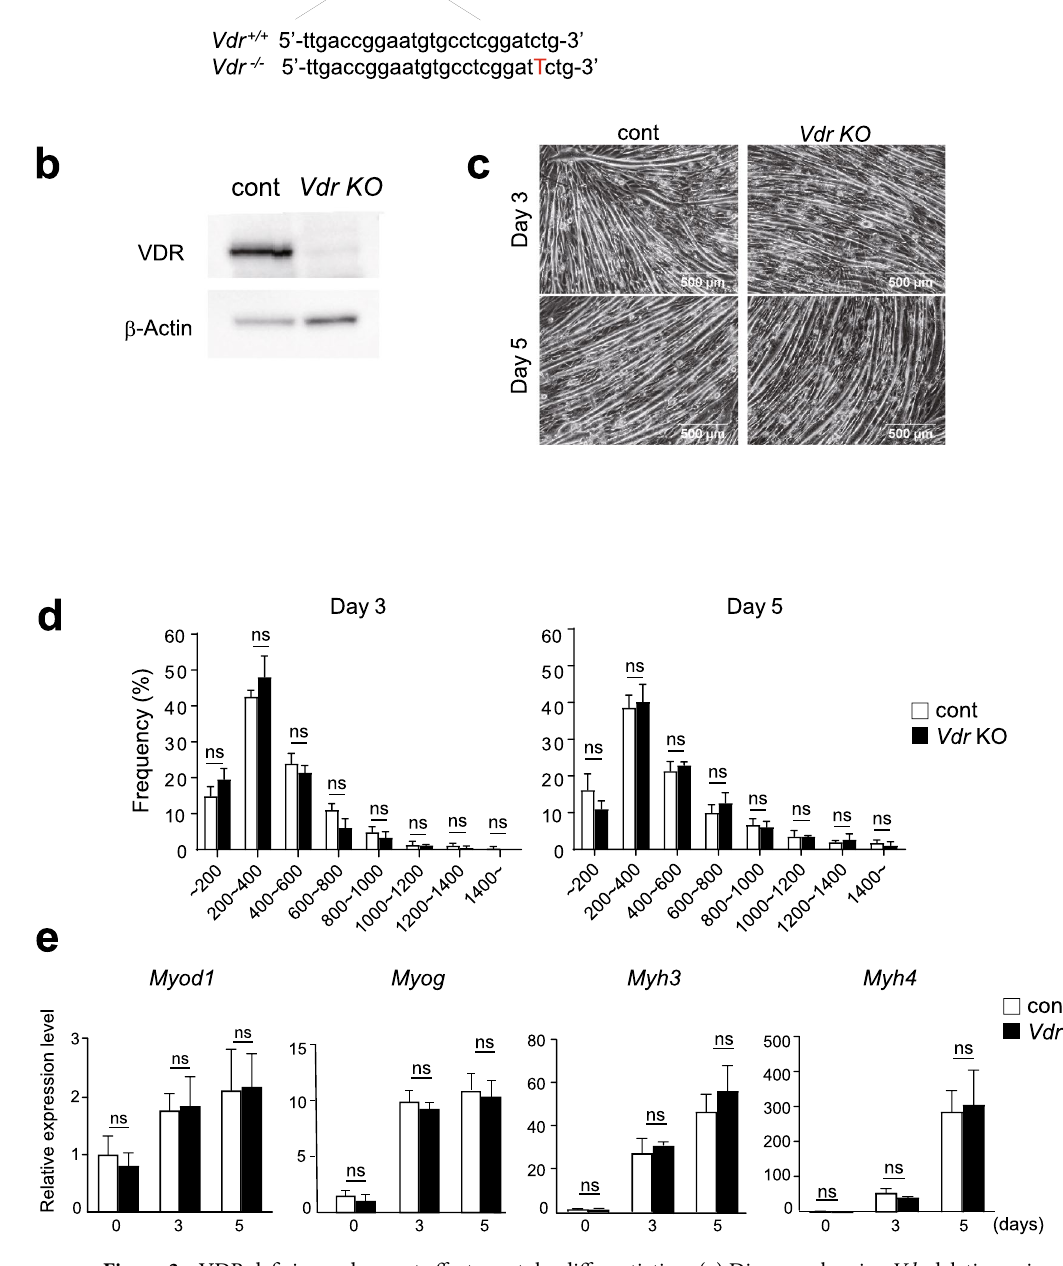
Figure 3. VDR deficiency does not affect myotube differentiation. ( a ) Diagram showing Vdr deletion using the CRISPR-Cas9 system. ( b ) Western blot of VDR and β-Actin in C2C12 myotubes confirming that VDR expression was absent in Vdr KO cells. ( c ) Phase contrast images of control and Vdr KO C2C12 cells after differentiation for 3 or 5 days. Scale bars; 500 μm. ( d ) Distribution of myotube lengths. Data are means ± s.d. Mean numbers of myotubes within the indicated length ranges per 100 myotubes in control and Vdr KO C2C12 cells after differentiation for 3 or 5 days. Data are means ± s.d. Two-way ANOVA and multiple Mann–Whitney tests for multiple comparisons. ns: no significant. ( e ) Myod1, Myog, Myh3 and Myh4 mRNA expression in control and Vdr KO C2C12 cells after differentiation for 0, 3, or 5 days. Data are means ± s.d. Two-way ANOVA and multiple Mann–Whitney tests for multiple comparisons. ns: not